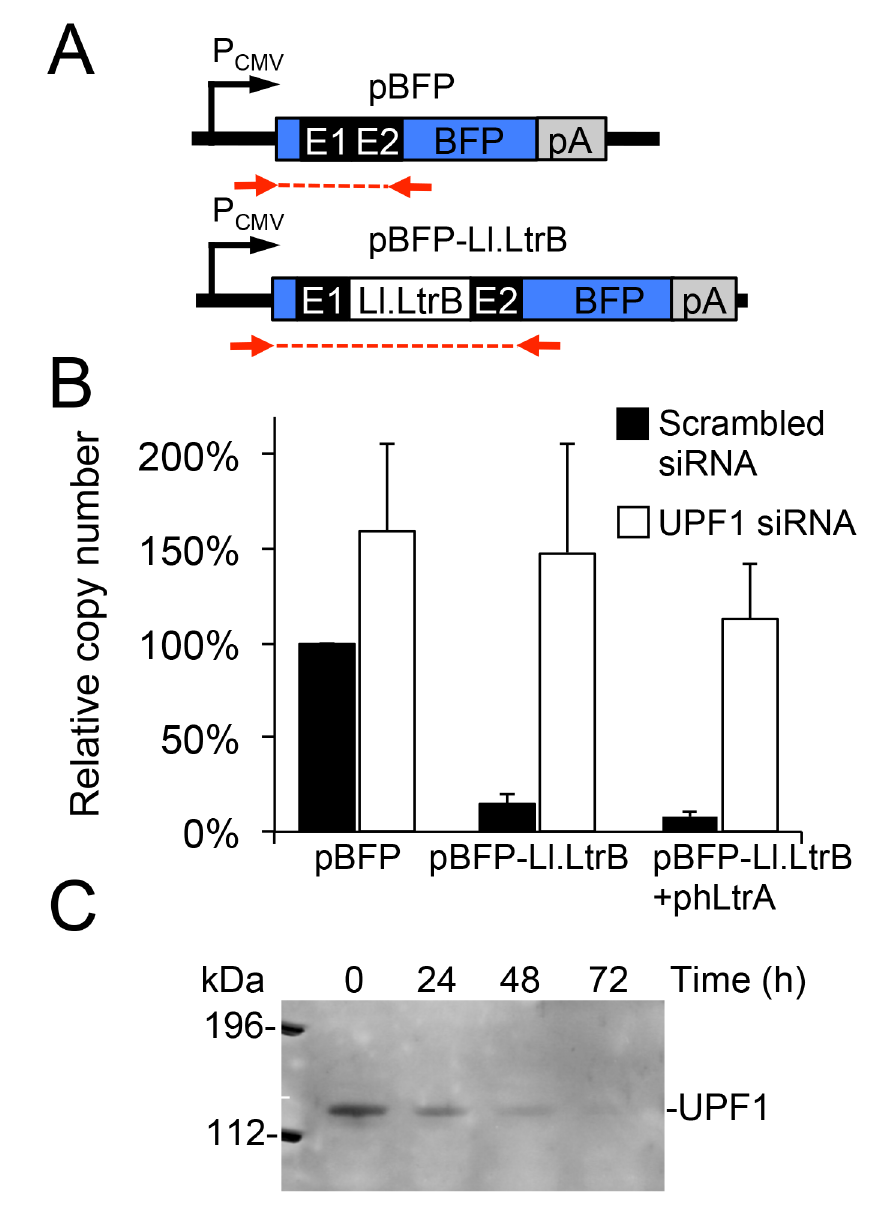
Fig 3. A Pol II transcript containing the Ll.LtrB intron is subject to nonsense-mediated decay in human cells. (A) Diagram of plasmid-borne P CMV transcription cassettes with or without the Ll.LtrB intron and short flanking exons inserted directly after the start codon of BFP. Red arrows indicate primers used for RT-qPCR analysis of transcript levels. (B) RNAi knockdown of UPF1. HeLa cells were pretreated for 24 h with either a scrambled siRNA (black) or UPF1 siRNA (white) to inhibit NMD, and then transfected with BFP expression plasmids with or without the Ll.LtrB intron and short flanking exons inserted directly after the BFP start codon. At 48 h after transfection of the plasmids, the number of transcripts per cell was measured by RT- qPCR, and normalized to that of the pBFP transcript in the presence of the scrambled control siRNA assayed in parallel. The bar graphs show the average ± the SD for two or three replicates for each condition. (C) Immunoblot showing knockdown of the NMD protein UPF1 at 72 h after transfection of the UPF1 siRNA corresponding to the time at which BFP transcript levels were measured. Equal amounts of cellular proteins were loaded in each lane. This immunoblot control was done twice with similar results. Abbreviations: E1 and E2, 5 ’ and 3 ’ ltrB exons, respectively; pA, polyadenylation signal; PCMV, cytomegalovirus immediate-early promoter.